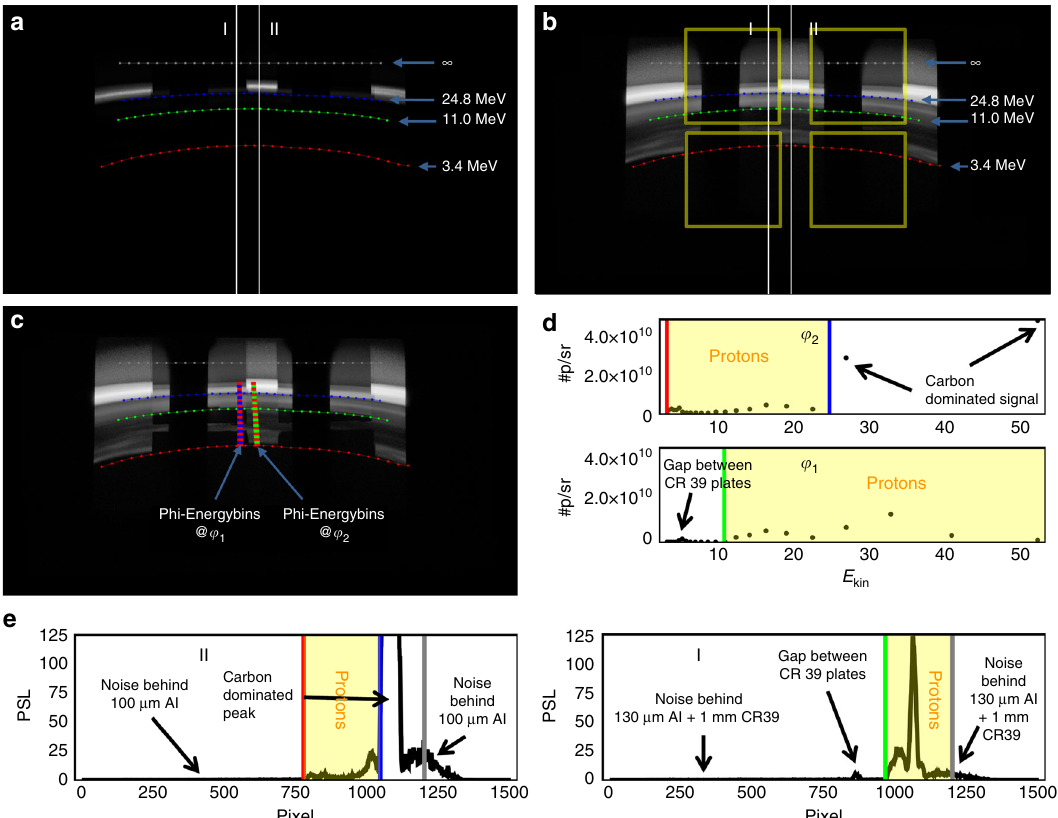
Fig. 9 Image Plates data: a raw data with iso-energy lines for protons, b logarithmic representation of a , yellow squares indicate the position of CR39 plates, c energy-angle bins on the detector, d spectra obtained from c , e PSL raw data